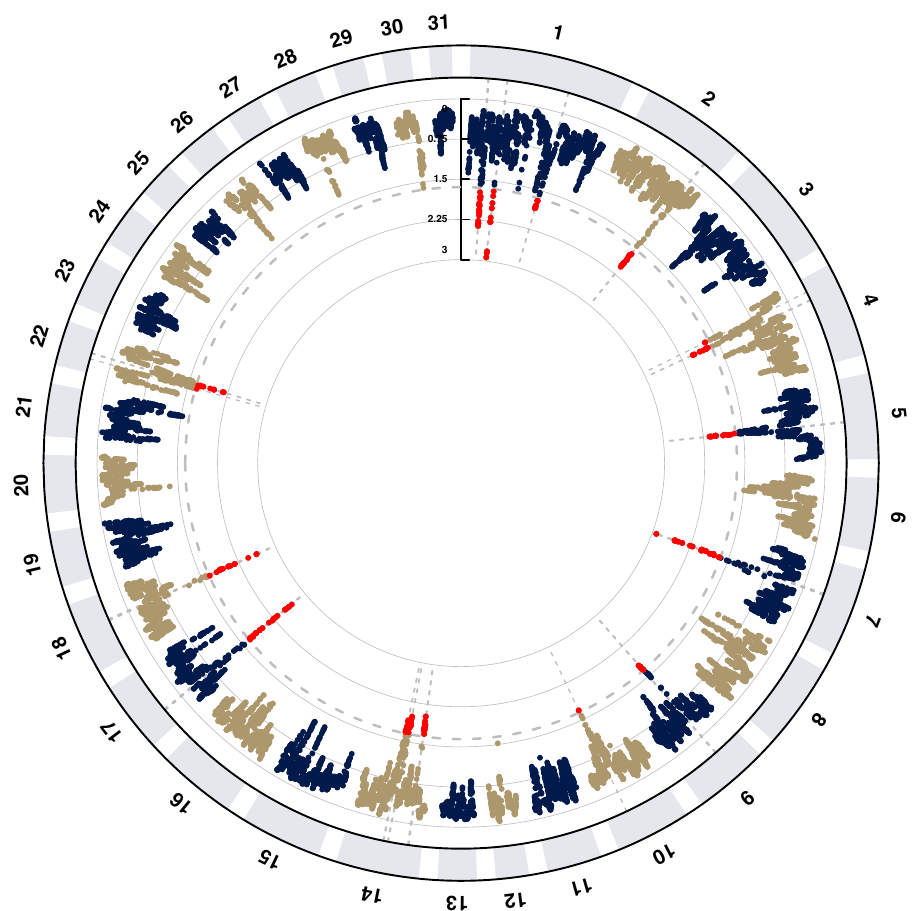
Fig. 3 Manhattan plot for the results of the composite selection signals (CSS) analysis to detect targets of selection among Racing breeds ( n = 90 horses) when compared with non-Racing breeds ( n = 483 horses). Non-Racing breeds had the following phenotypes: draft, small size, riding, driving, gait. Detailed information for the breeds used is provided in Supplementary Data 2. The results were obtained by averaging the CSS scores of SNPs within 100 kb sliding windows. The dashed grey line indicates the genome-wide (1% SNPs) threshold of the empirical scores and the top SNPs are indicated by red